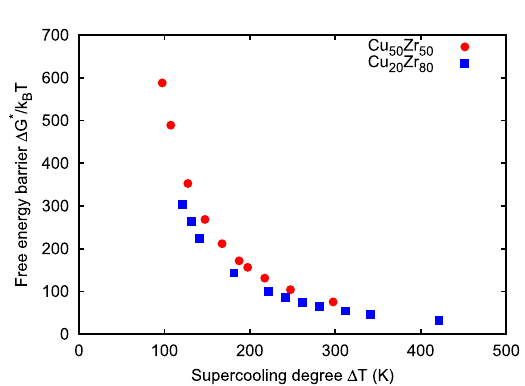
Figure 3. Temperature dependent interfacial free energy.